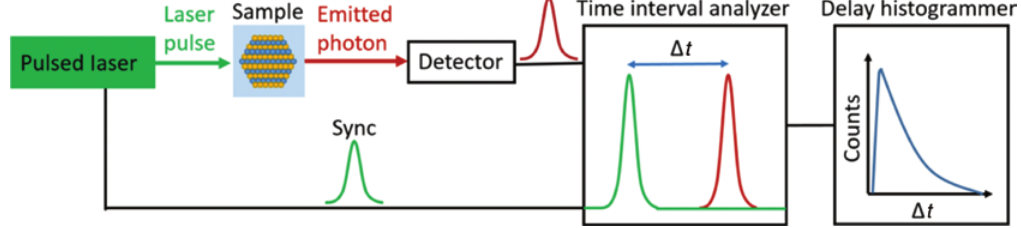
Figure 11: The sketch of the time-correlated single-photon counting (TCSPC) system. The pulsed laser excites the sample. The detector registers the photons emitted from the sample. The time interval analyzer is used to measure the time delay between the sync electronic signal from the laser producing the pulse and the electrical signal from the detector corresponding to the registered photon. The delay histogrammer collects and processes the statistical